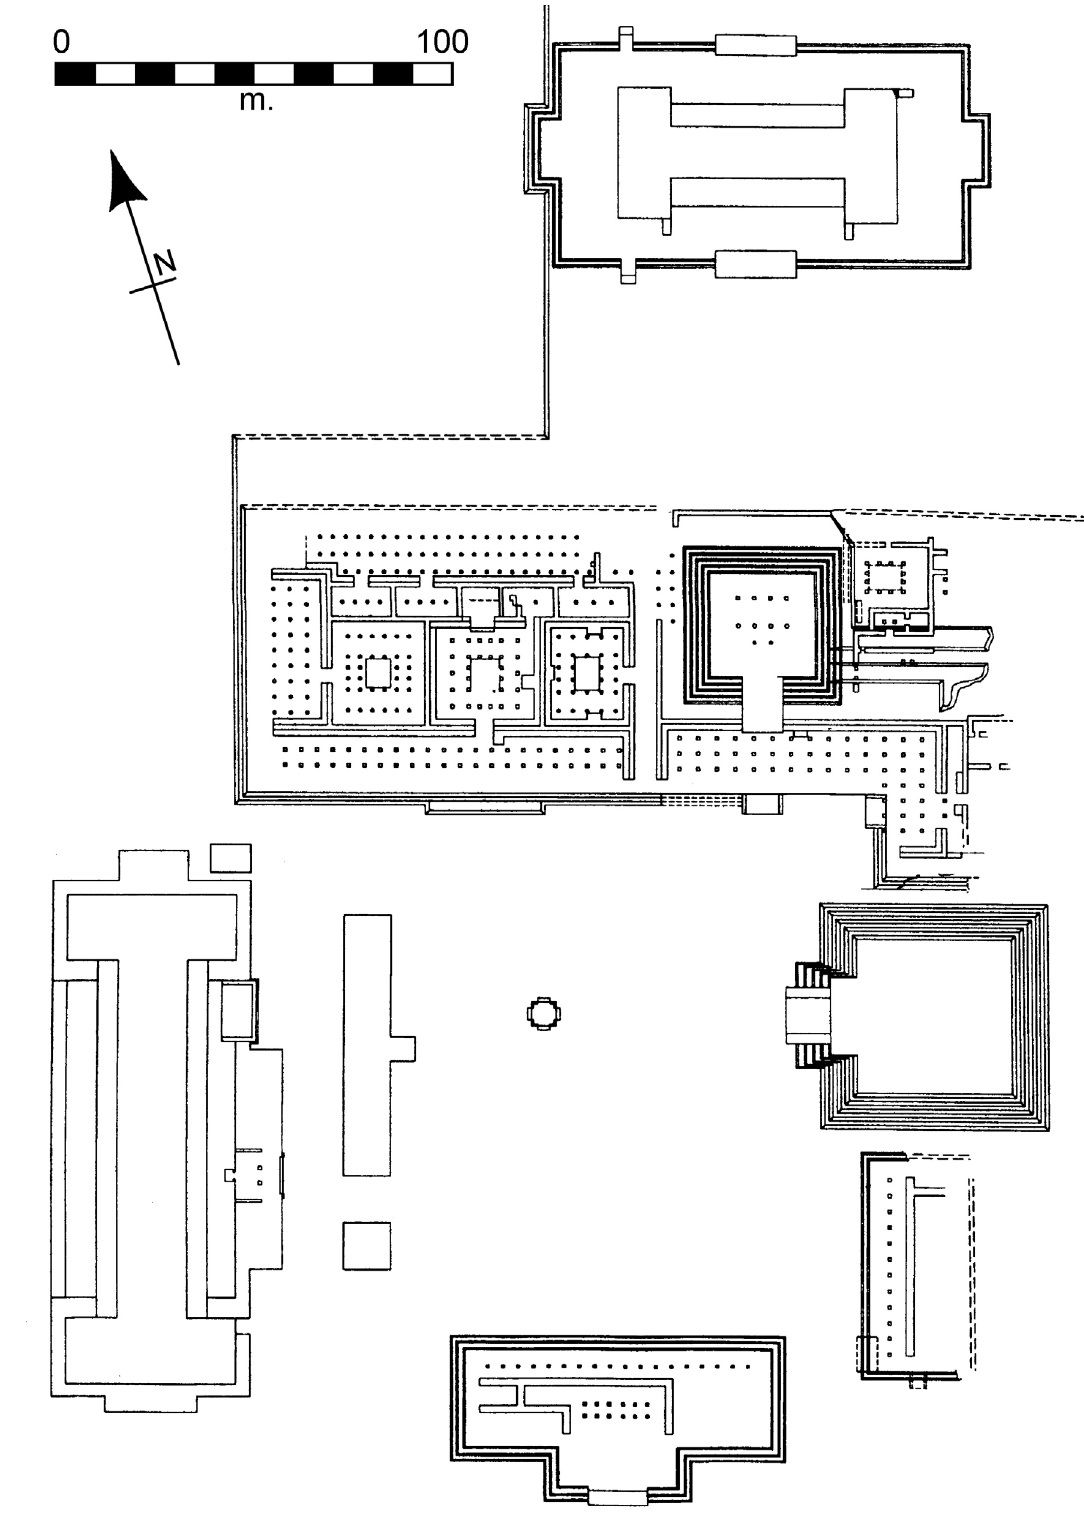
Figure 7. Plan of the epicenter of Tula. Modified after Mastache et al.